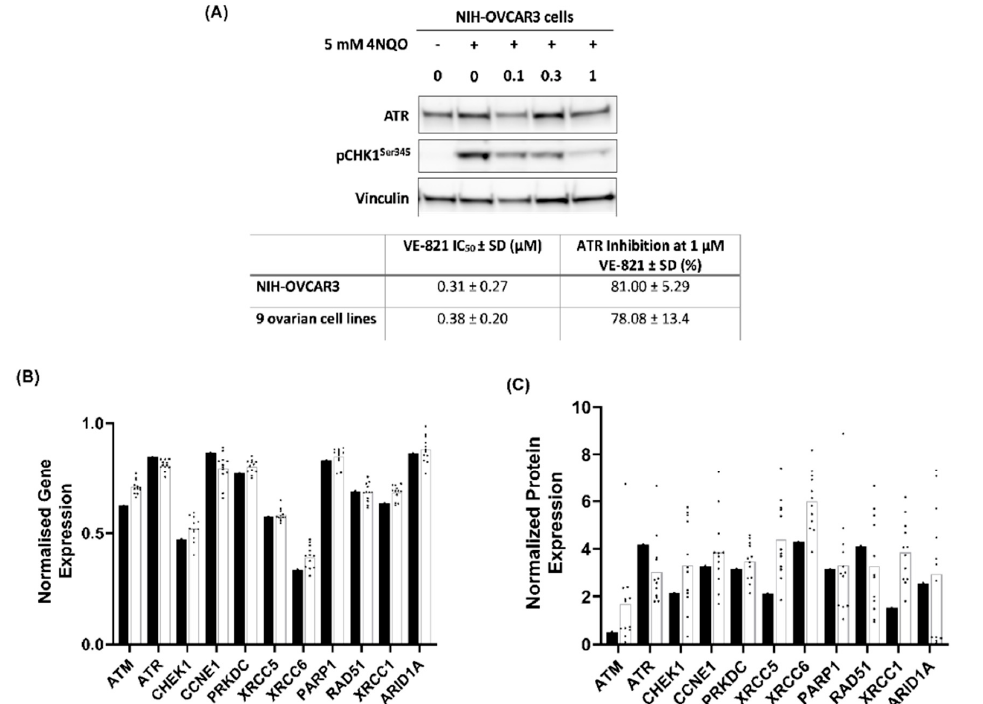
Figure 3. Inhibition of ATR by VE-821 and the expression of potential determinants of sensitivity and resistance to VE-821 in the NIH-OVCAR3 cells. ( A ) NIH-OVCAR3 cells and 9 other ovarian cancer cell lines were exposed to 4NQO ± VE-821 as indicated for 1 hr before western blotting. Chemiluminescence was quantified using Syngene software and expression of pCHK1Ser345 was normalised to vinculin expression. Western blot image is from a single representative experiment with pooled data from 3 independent experiments per cell line used to calculate the mean VE-821 IC50 and percentage inhibition at 1 µM VE-821. ( B ) Bar chart represents log-transformed read counts obtained from RNA-Seq data for each gene normalized to ACTB mRNA expression for NIH-OVCAR3 cells ( black bars ) and the mean mRNA expression of each gene across 12 cell lines ( white bars ) where each black dot represents one cell line. ( C ) Bar chart represents protein expression normalised to Ponceau-s staining calculated using ImageJ software in NIH-OVCAR3 cells (black bars) and the mean protein expression of each gene across 12 cell lines ( white bars ) where each black dot represents one cell line. Data are from a single experimental repeat. [PRKDC: DNA-PKcs, XRCC5: Ku80, XRCC6: Ku70]. Western blot of ATR activation and inhibition by 4NQO ± VE-821 in NIH-OVCAR3 cells can be found at Figure S4. Western blot of baseline protein expression in panel of ovarian cancer cell lines can be found at Figure S5.